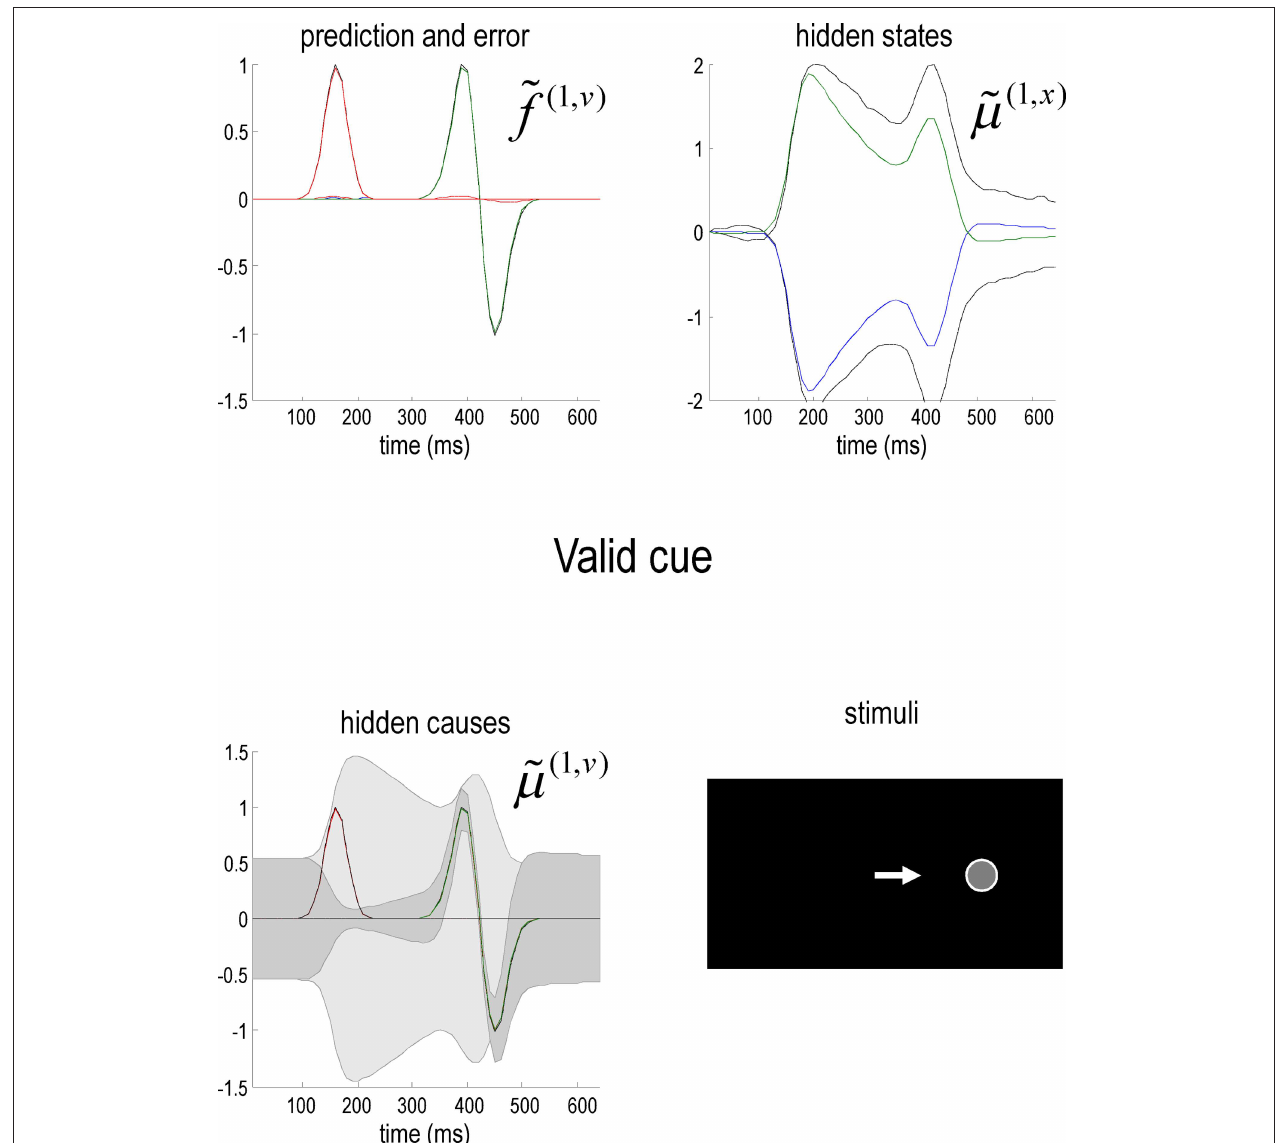
below. The gray areas correspond to 90% conditional confidence tubes; this confidence reflects the estimated precision of the sensory data, which is encoded by the expectations of the hidden states in the upper right panel. The green line and green s C L corresponds to a precision or attentional bias to the right x R ( )1 and the blue line to ( ) . 1 They gray lines are the true precisions. Lower right panel: this insert the left x L ( ) ( ) ( ) , , 1 1 1 are shown indicates the sort of stimuli that would be generated by these hidden R C L